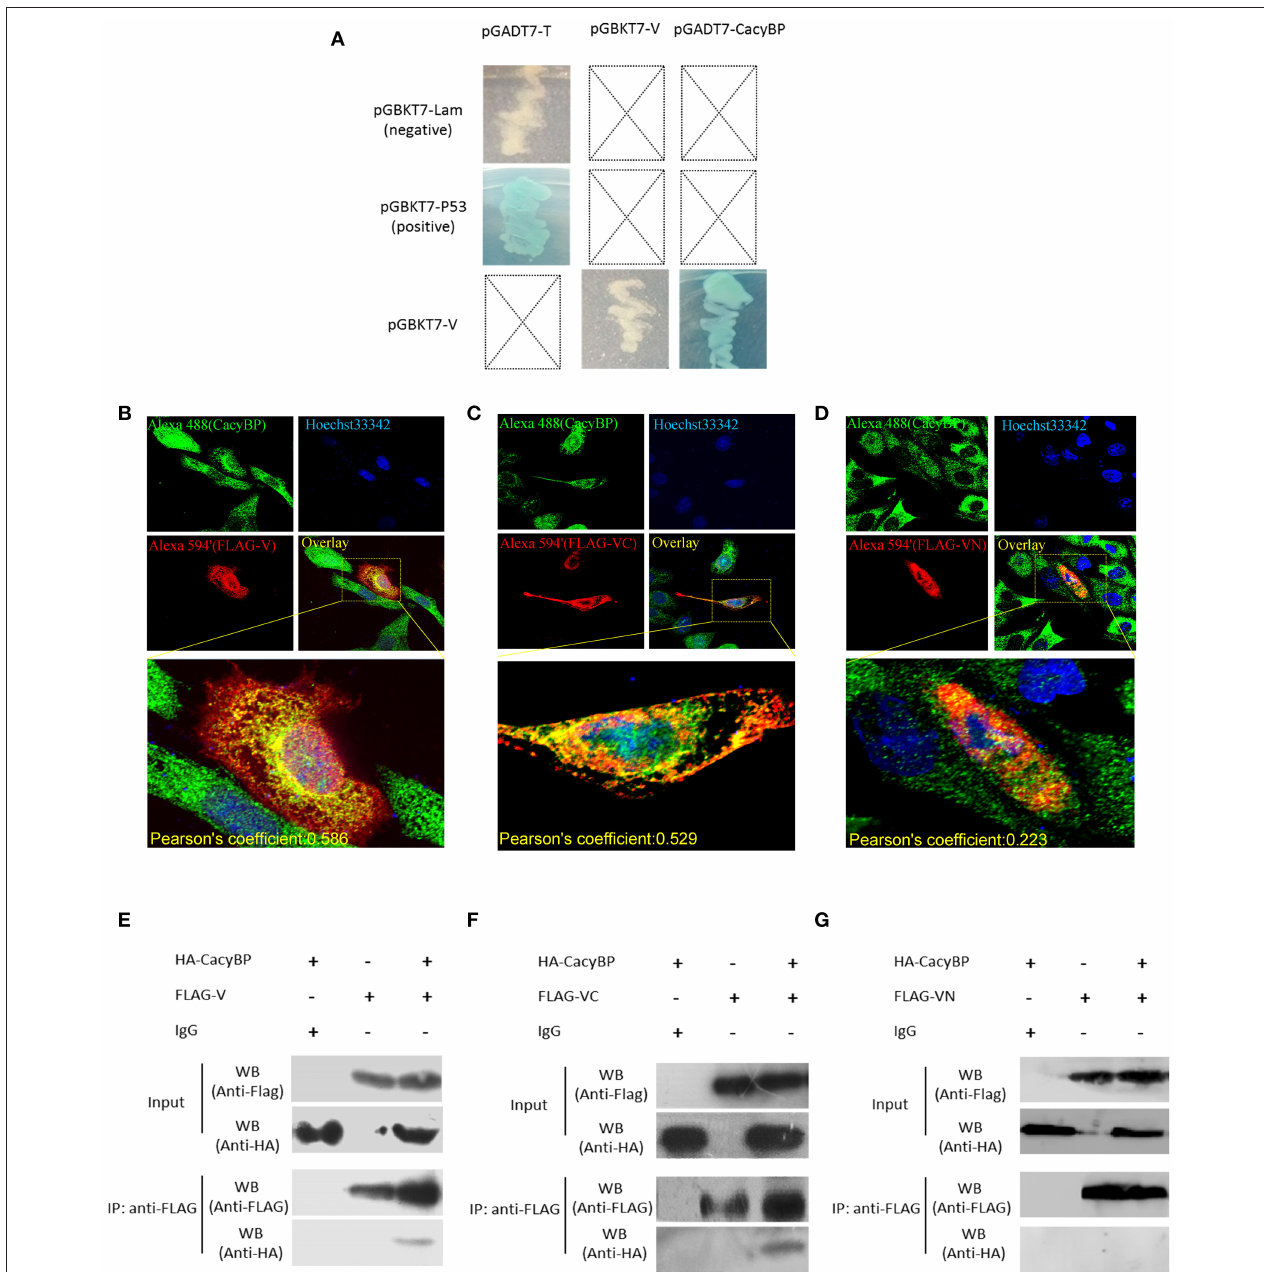
FIGURE 2 | CacyBP bound to C-terminal domains of V protein. (A) Identification of protein interaction partners of V protein by yeast two-hybrid screening of a CEF cDNA library. (B–D) Co-localization of CacyBP with V, VC, and VN proteins in DF-1 cells. DF-1 cells were plated on coverslips and transfected with Flag-V, Flag-VN and Flag-VC. Forty-eight hours after transfection, the cells were stained with mouse anti-FLAG and rabbit anti-CacyBP antibodies, which was followed by staining with donkey anti-rabbit Alexa Fluor ® 488 (green) and goat anti-mouse Alexa Fluor 594 (Red) as secondary antibodies. The nucleus was subsequently stained with Hoechst 33342, and the images were captured using an ANDOR Revolution WD confocal microscope. Pearson’s coefficient were analysis by Imaris (Microscopy Image Analysis Software, Bitplane, Switzerland), and Pearson’s coefficient > 0.5 were considered to be probable co-localization. (E–G) HEK-293T cells in 60mm cell culture dishes were co-transfected with the pCAGEN-Flag-V (or Flag-VN or Flag-VC) and pCMV-HA-CacyBP expression plasmids. Transfected cells were harvested and lysed 48h after transfection, and the experiment was conducted according to the manufacturer’s instructions for the Co-Immunoprecipitation Kit. After washing, immunoprecipitated proteins were identified and analyzed by western blotting using anti-HA or anti-FLAG antibodies.